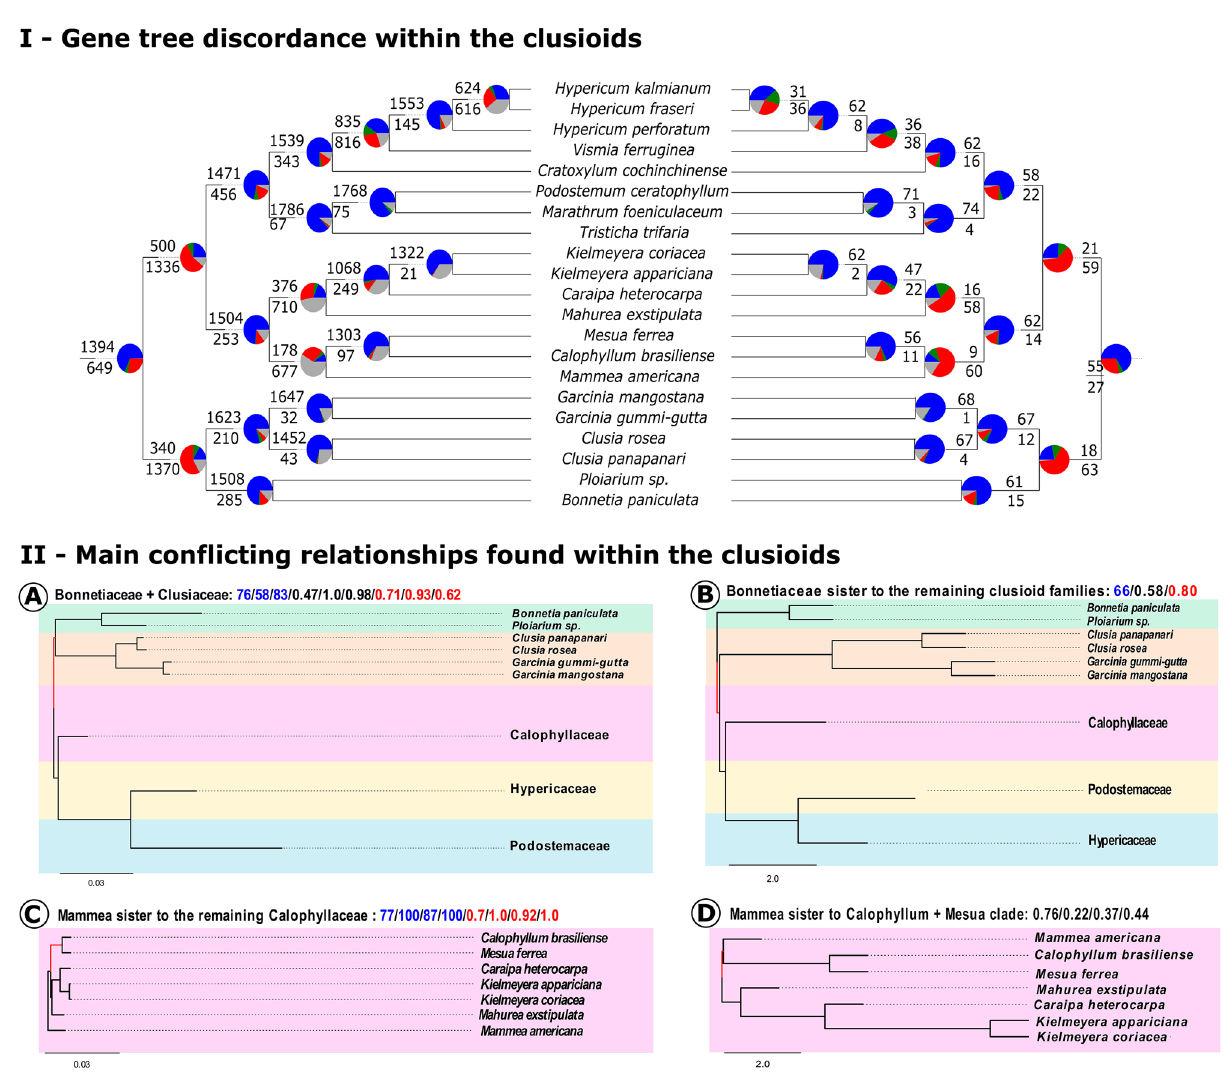
Figure 5. Relationships within the clusioid families and summary of conflicts. On the top, (I) Gene tree discordance within the clusioids represented in the coalescent-based species tree. Pie charts summarize the proportion of conflicting (red and green), concordant (blue) and non-informative (gray) genes for each branch. Numbers above branches indicate concordant genes at that node, and below conflicting genes. On the right the tree generated with one tree for each of the 82 genes (82), and on the left the tree generated with 25 independent replicates for each of the 82 genes (2050), both after removal of poorly aligned sequences (gb). On the bottom, (II) Summary of the main conflicting relationships recovered using maximum-likelihood (values in blue), Bayesian inference (values in red), and multispecies coalescent (values in black) and eight different datasets (CU: 82 protein-coding genes concatenated unpartitioned, CP: 82 protein-coding genes partitioned with individual evolutionary models, 82: a single consensus gene tree per locus used as input, 2050: 25 consensus gene trees from independent runs per locus used as input; each of these four datasets have two versions: one without removal of poorly aligned regions–nogb, and one after removal using Gblocks 50 –gb). On the top of each tree there are support values for the branch highlighted in red. The two upper trees ( A and B ) represent alternative topologies for the position of Bonnetiaceae and Clusiaceae families. The two bottom trees ( C and D ) represent alternative topologies for the position of Mammea americana (Calophyllaceae). Support values are represented by ultrafast bootstrap (UB) or posterior probability (PP), and the respective dataset (CUgb, CUnogb, CPgb, CPnogb, 82gb, 82nogb, 2050gb, 2050nogb) are in parenthesis. A. Bonnetiaceae sister to Clusiaceae: 76% (UB, CUgb)/58% (UB, CPnogb)/83% (UB, CPgb)/0.47 (PP, 82gb)/1.0 (PP, 2050gb)/ 0.98 (PP, 2050nogb)/0.71 (PP, CUgb)/0.93 (PP, CPgb)/ 0.62 (PP, CPnogb). B. Bonnetiaceae sister to the other clusioid families: 66% (UB, CUnogb)/0.58 (PP, 82nogb)/0.80 (PP, CUnogb). C. Mammea americana sister to the other Calophyllaceae species: 77% (UB, CUgb)/ 100% (UB, CUnogb)/ 87% (UB, CPgb)/ 100% (UB, CPnogb)/0.7 (PP, CUgb)/1.0 (PP, CUnogb)/0.92 (PP, CPgb)/1.0 (PP, CPnogb). D. Mammea americana in a clade with Calophyllum brasiliense and Mesua ferrea : 0.76 (PP, 2050gb)/0.22 (PP, 2050nogb)/0.37 (PP, 82gb)/0.44 (82PP,